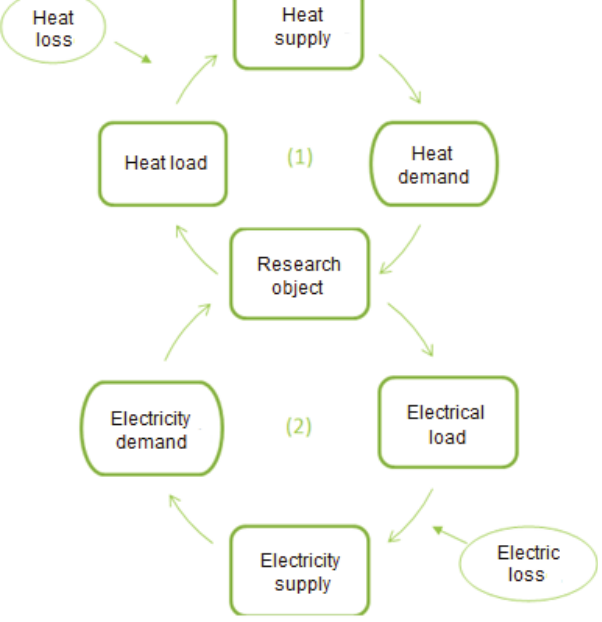
Fig. 6. Merging of causal loops (1) and